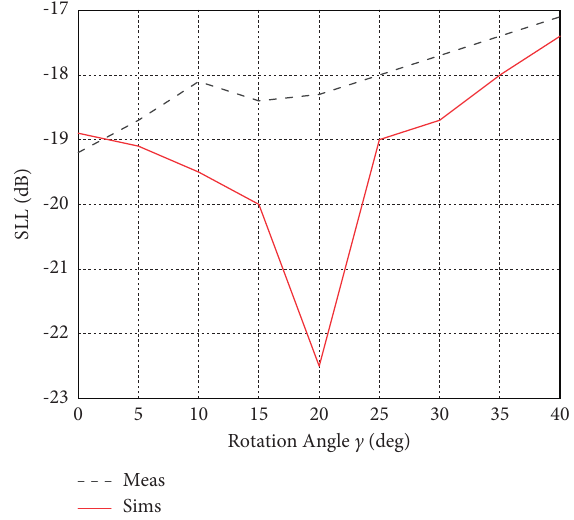
Figure 11: SLL at different rotation